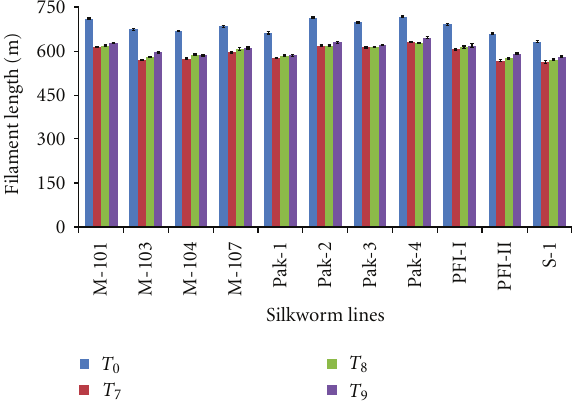
Figure 15: Comparative performance of filament length (mean ± SE) of eleven silkworm lines at 35 ± 1 ◦ C in combination with 55, 65, and 75% RH and controlled conditions of temperature and RH (25 ± 1 ◦ C and 70–80%,